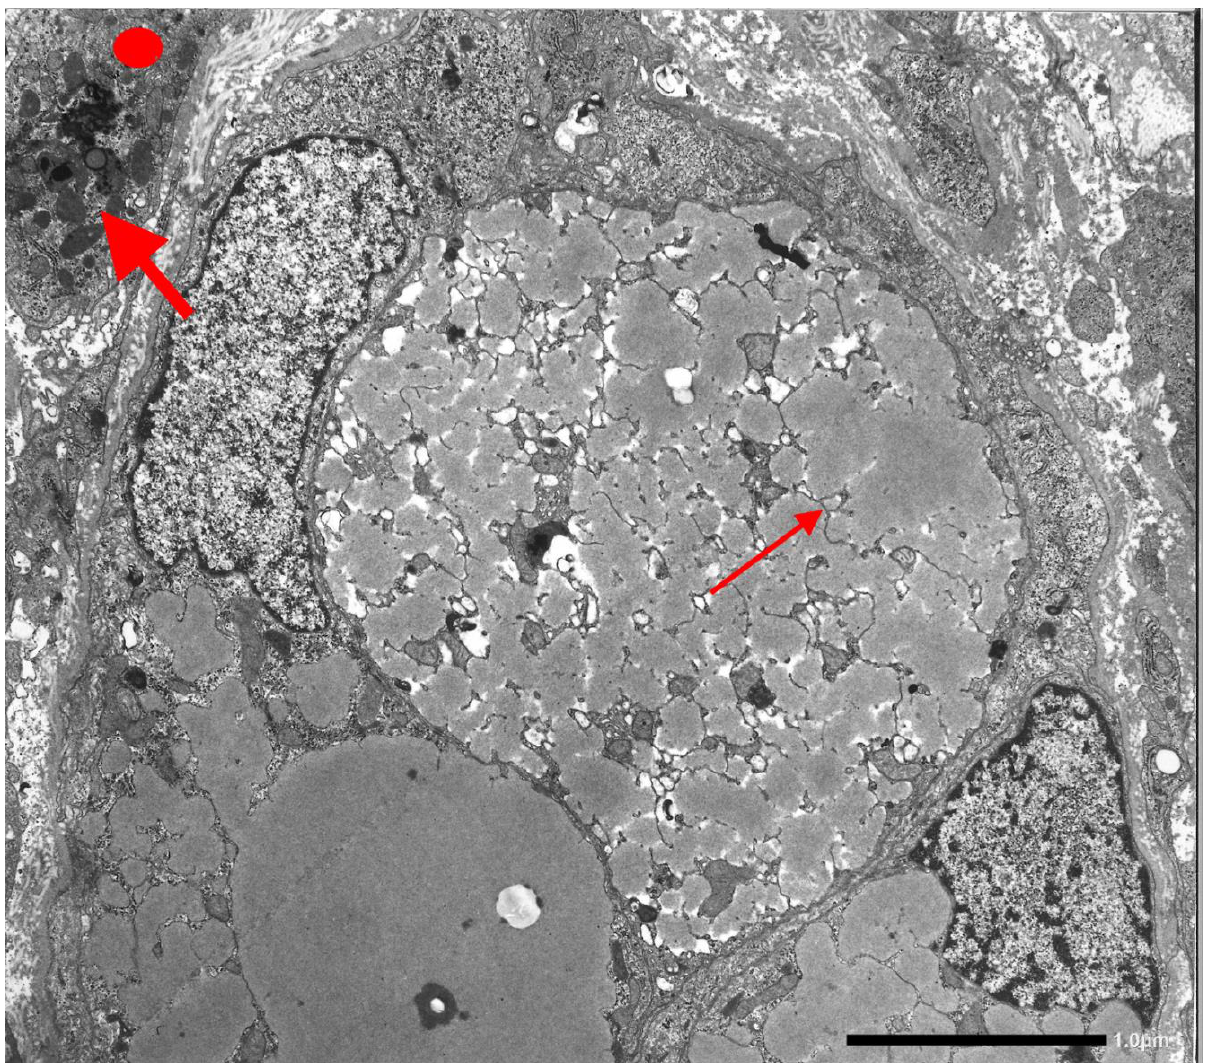
Figure 12. Pi ZZ liver. The cytoplasm of the hepatocytes is engulfed by Z AAT storage. Dilated cisternae of the RER contain AAT in the form of amorphous fluffy material and coalesce after disruptor of membranes and occupy the entire volume of the cell (thin arrow). Excess mitochondria (thick arrow) and glycogen rosettes (dot) indicate the periportal location of the cells (EM ×